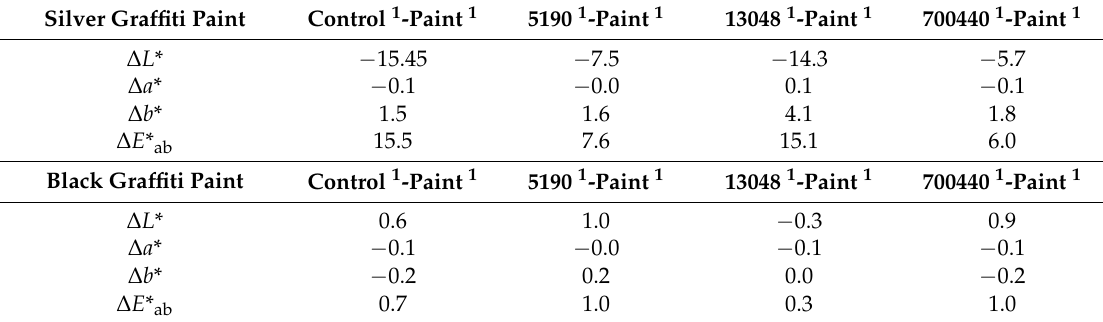
Table 2. Partial colour differences ( ∆ L *, ∆ a * and ∆ b *, CIELAB units) and total colour difference ( ∆ E * ab , CIELAB units) between the painted specimens of natural granite